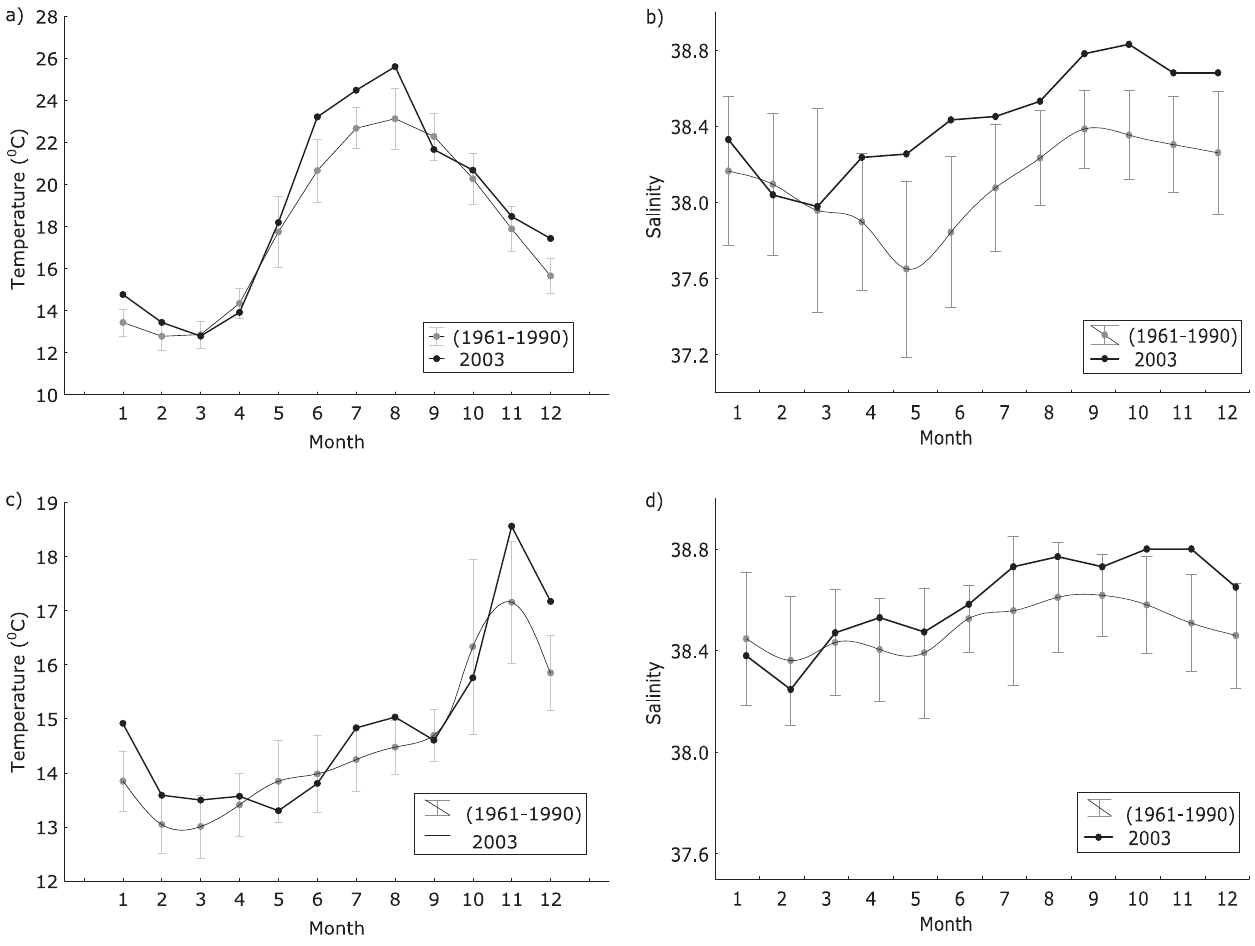
Fig. 5. Monthly mean surface temperature (a) and salinity (b) , and bottom temperature (c) and salinity (d) at the station CJ008 for the period 1961–1990 and for